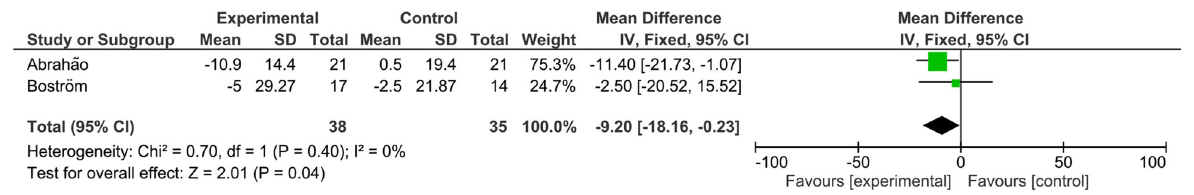
Fig. 4 Forest plot showing the results of the meta-analysis (intervention versus control- Domain Physical)